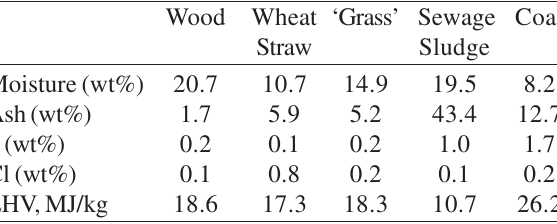
Table 1. Average analyses of biomass and fossil fuels.